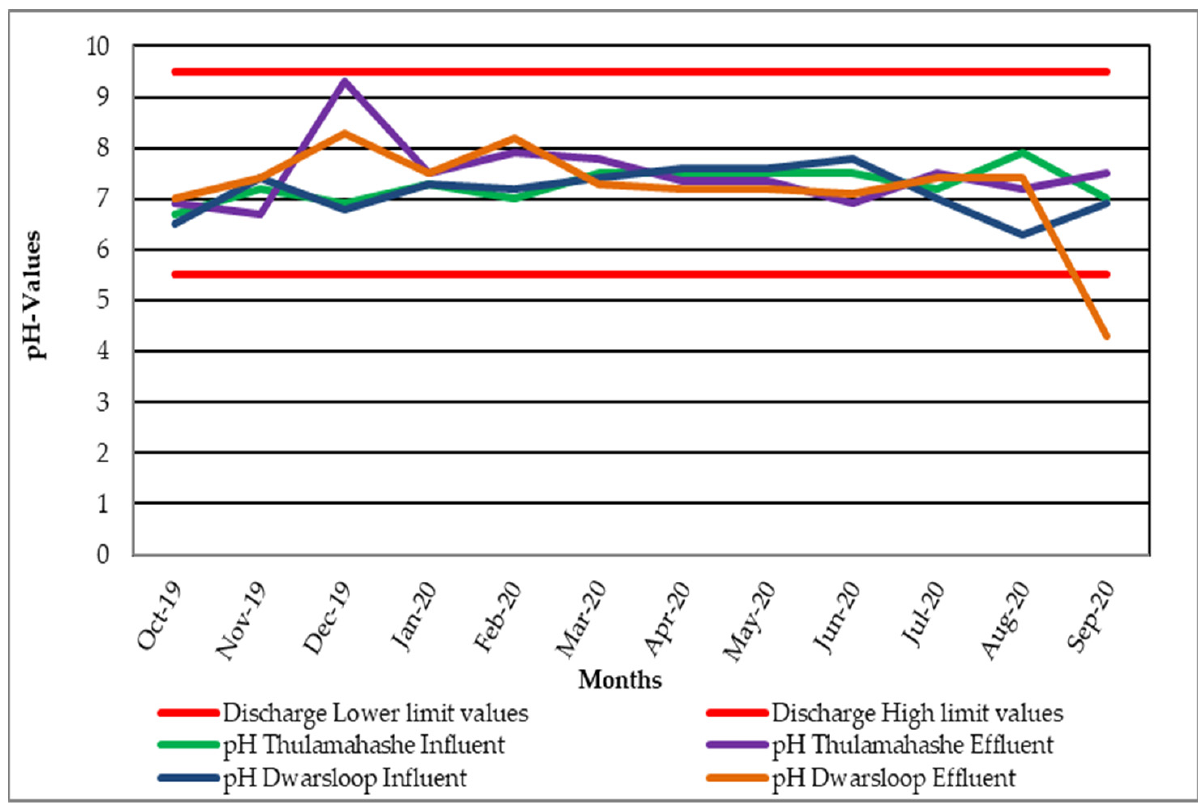
Figure 5. pH-values in